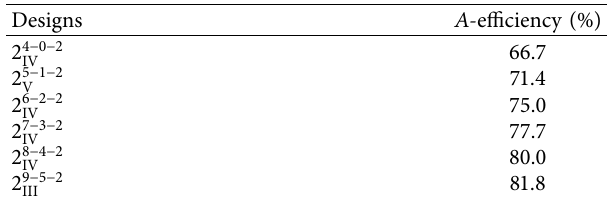
Table 4: Design efciencies’ design and block generators for m � 4, 5, 6, 7, 8, and 9 with 4 choice sets of size